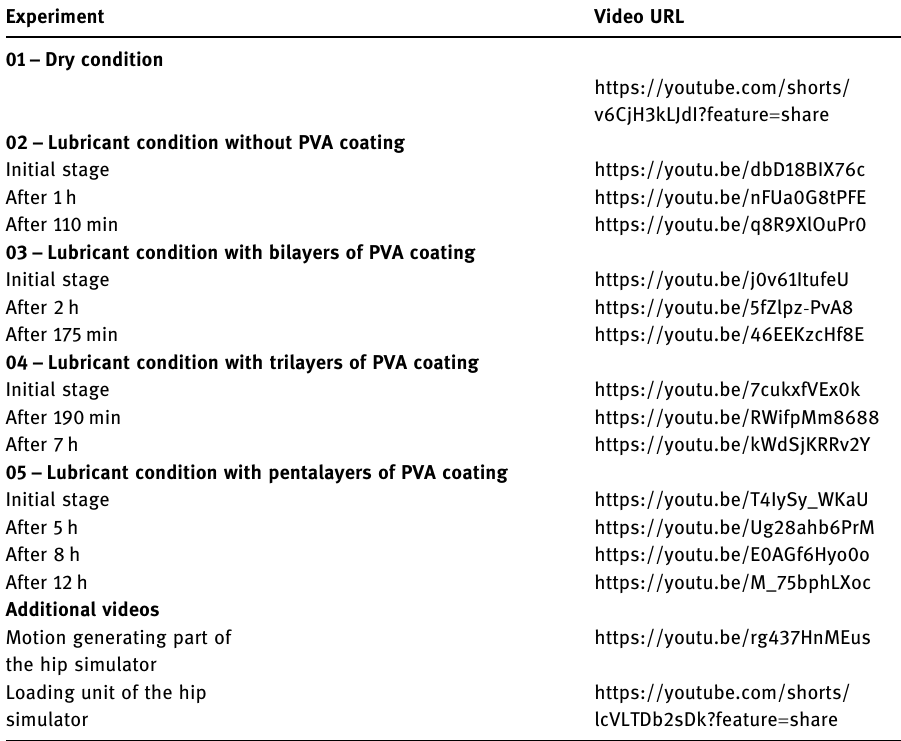
Table A1: URL links for some of the experiments that were carried out during this research ( the fi rst column describes the test condition and the time measured from the start of experiment )